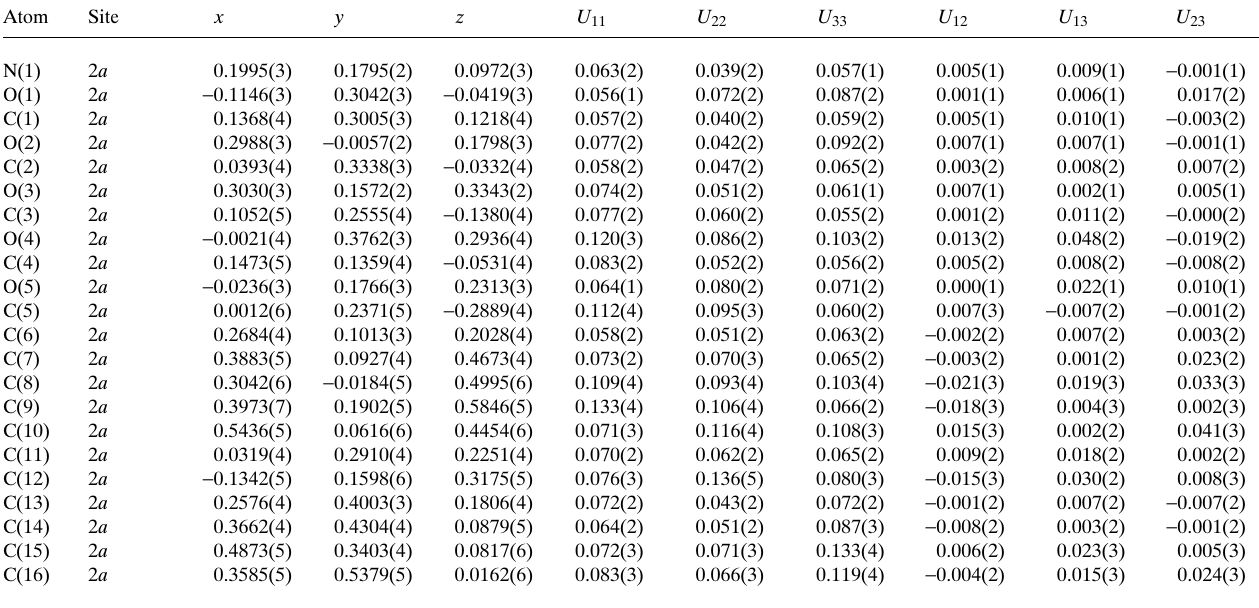
Table 3. Atomic coordinates and displacement parameters (in Å 2 )